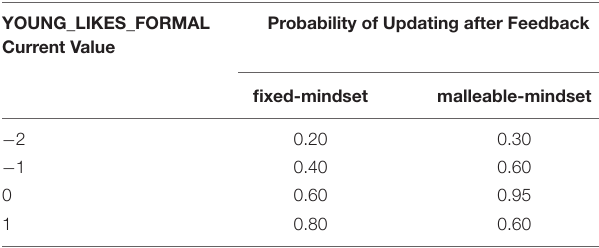
TABLE 3 | Real-world model for belief updating of fixed-mindset and malleable-mindset players. YOUNG _ LIKES _ FORMAL Current